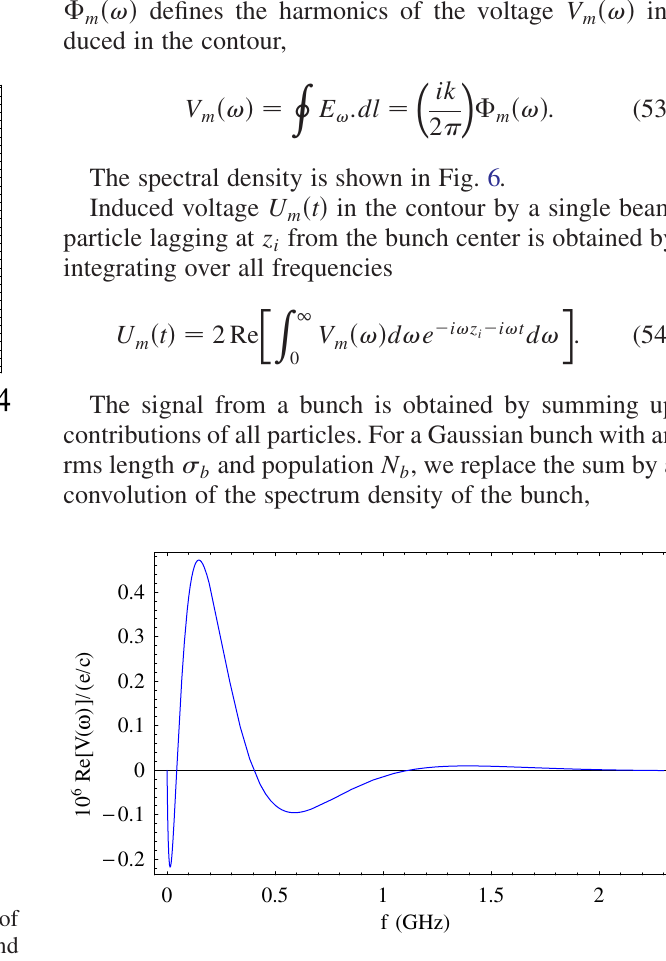
ð ! Þ of the dipole harmonics FIG. 6. (Color) Spectral density V m m ¼ 1 of the azimuthal B (cid:7) field per single beam particle, L ¼ 10 cm . Other parameters are the same as in Fig.